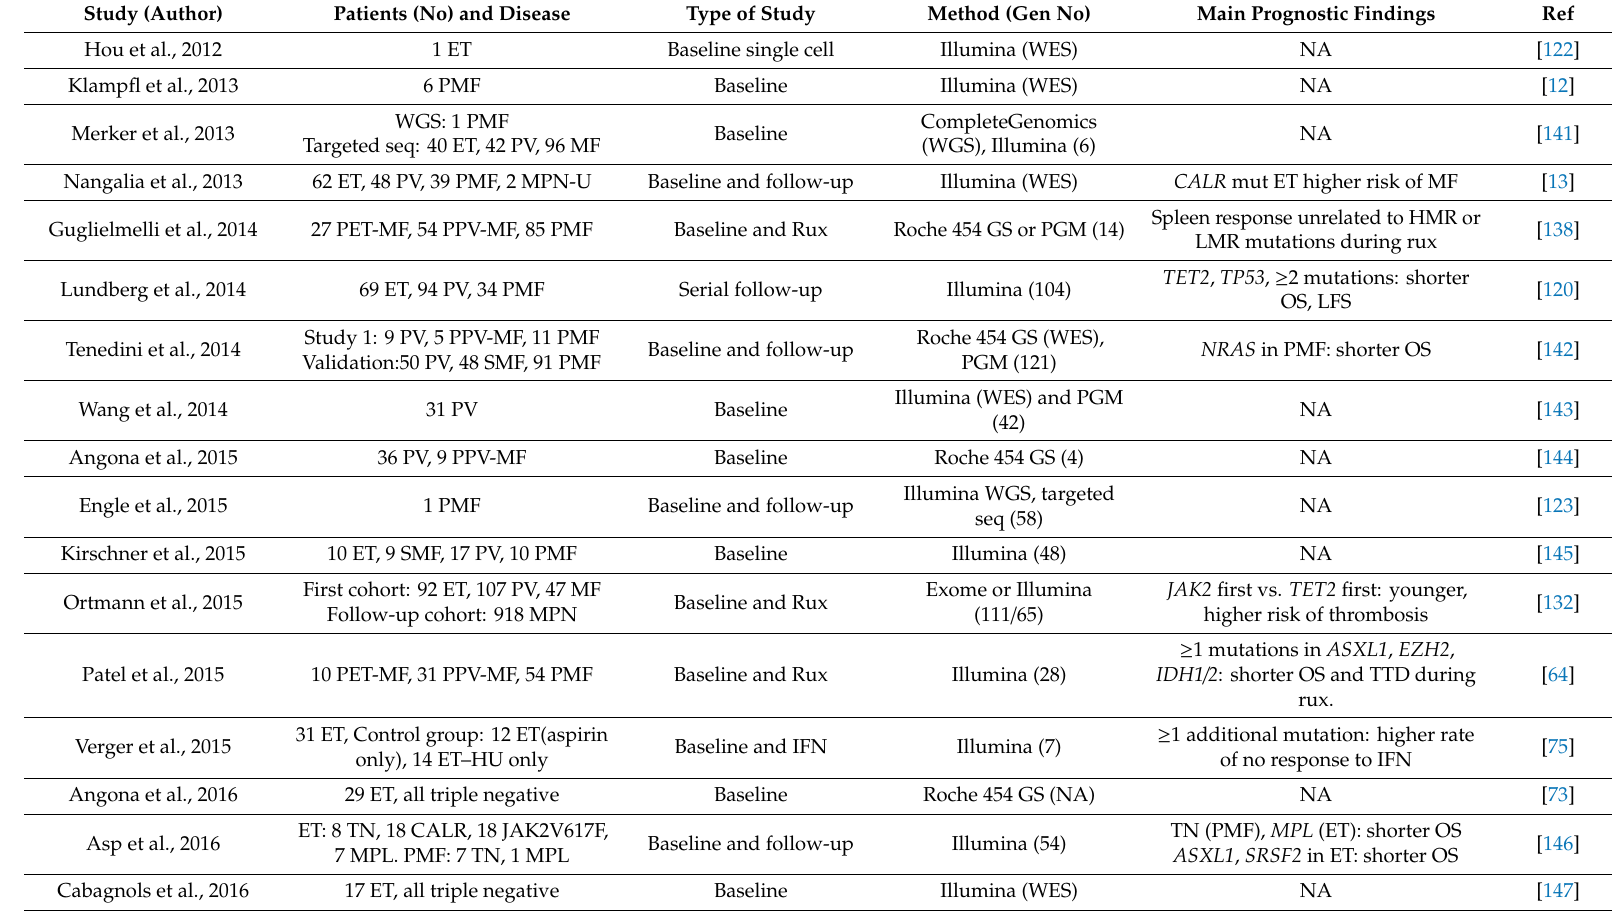
Table 2. NGS studies in patients with